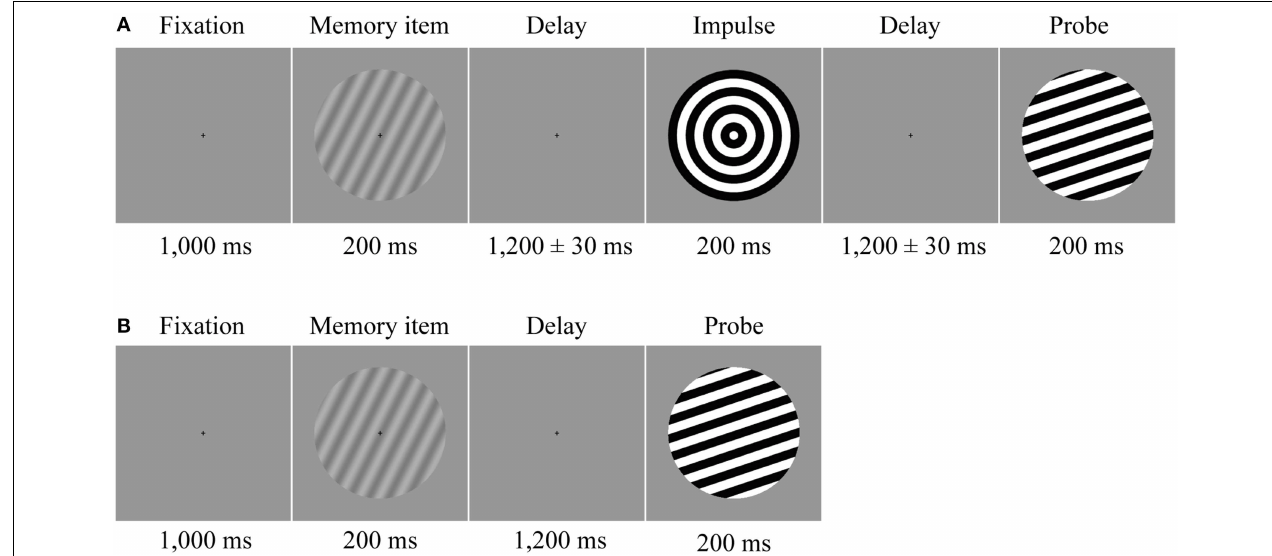
FIGURE 1 | Trial structure. Participants memorized the orientation of a low contrast sine-wave grating. (A) In half of the trials a neutral impulse stimulus was shown after the initial delay. The onset of the impulse was jittered by ± 30ms. The force-choice discrimination memory probe was presented after a second delay period. (B) In the other half of the trials, determined randomly, the probe was presented instead of the impulse after the first delay.